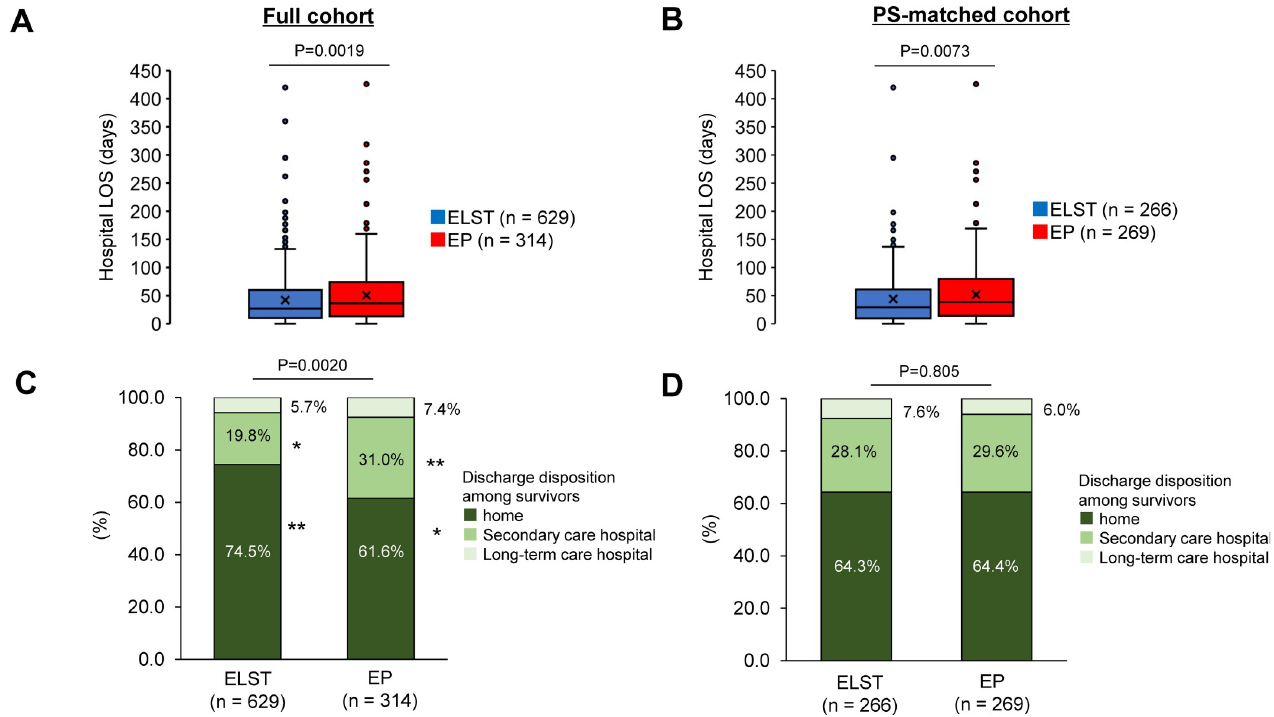
Fig 4. Differences in hospital LOS and disposition location among survivors: EP-staffed ambulance versus ELST-staffed ambulance. Hospital LOS among survivors in the full (A) and PS-matched (B) cohorts. Solid line inside the box represents the median, x represents the mean, the box represents the 25th and 75th percentiles, the whiskers represent the lower and upper extremes, and the circles represent outliers. Disposition location of survivors in the full (C) and PS-matched (D) cohorts. �� Adjusted standardized residual > 1.96 and � adjusted standardized residual < − 1.96. ELST, emergency life-saving technician; EP, emergency physician; LOS, length of stay; PS, propensity